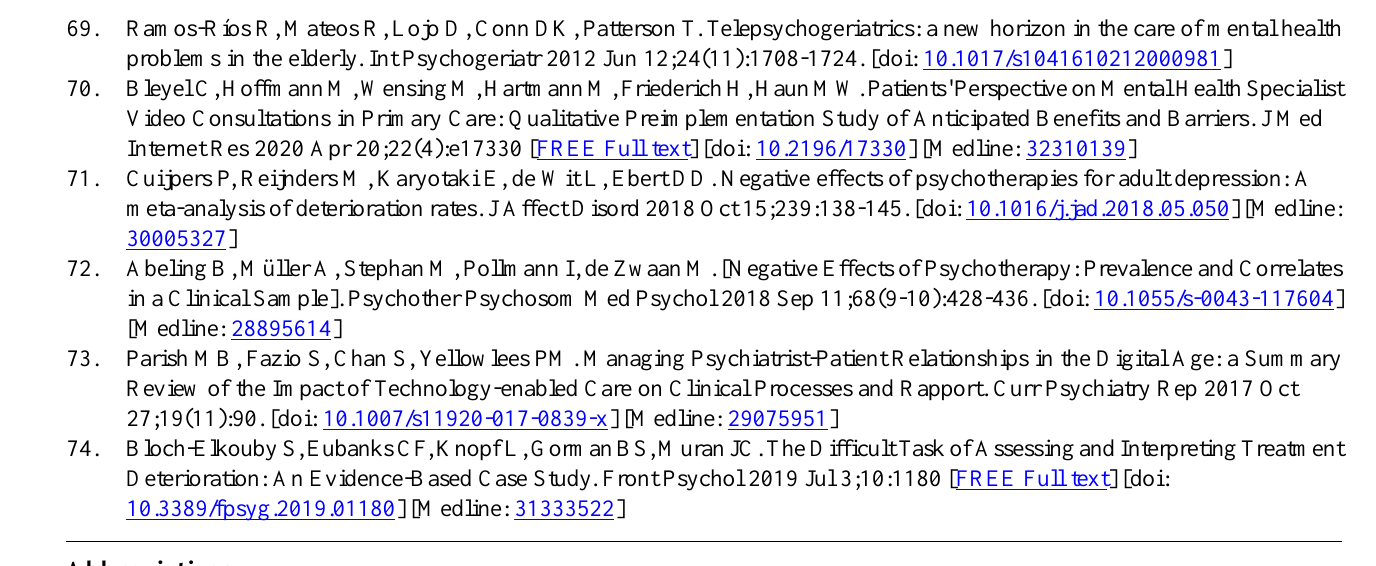
GAD-7: Generalized Anxiety